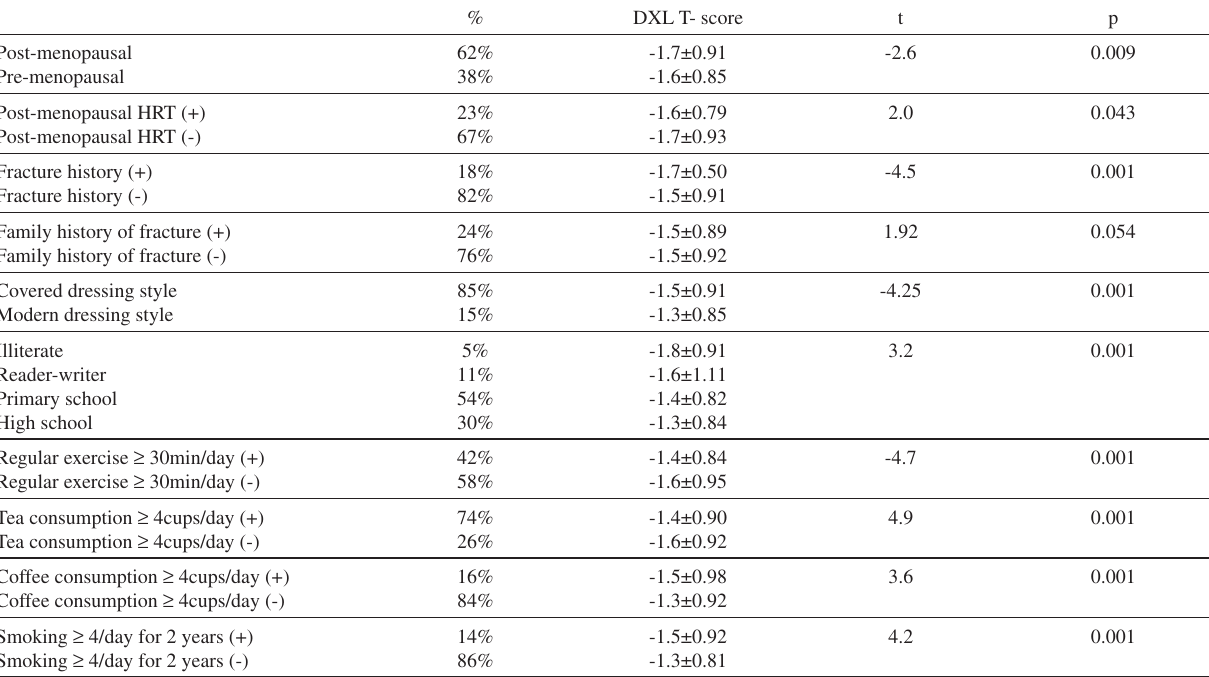
Table 3 - Categorical variables of osteoporosis risk factors and differences between groups in terms of the DXL T-score (values are presented as mean±SD for the DXL T-score) %